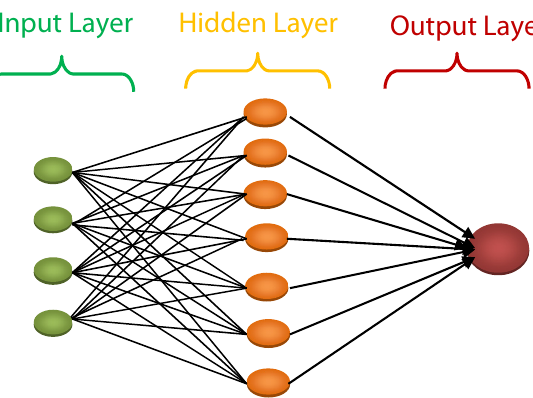
Figure 2: Flow - chart of the multilayered ANN model system studied [ 18 ]